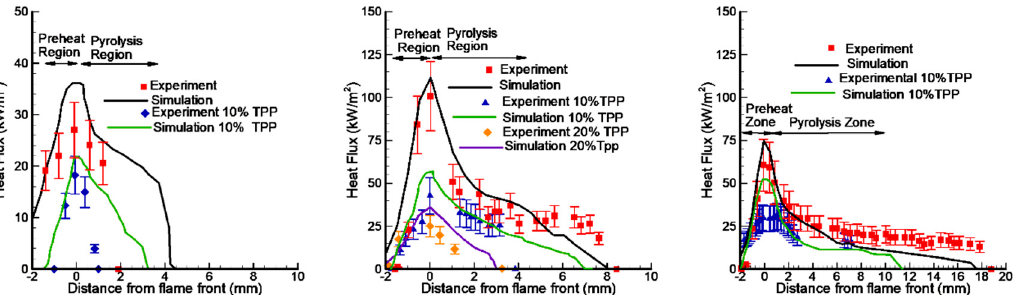
Figure 13. The downward flame ‐ spread rate as a function of the distance from the slab edge.